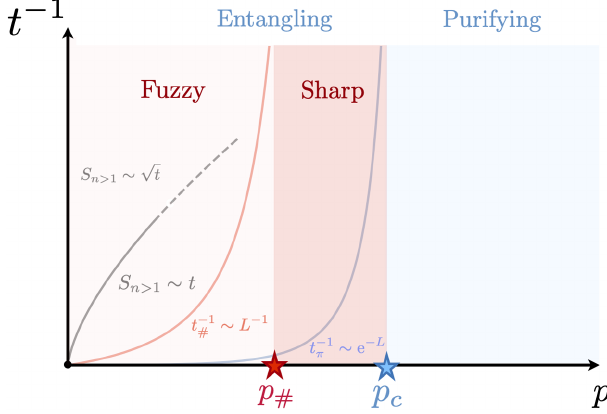
FIG. 1. Phase diagram and crossover timescales in U(1) symmetric monitored quantum circuits. Our numerical results indicate that there are two distinct phases in the entangling (volume-law) regime p < p , separated by a charge-sharpening c critical point as p ¼ p # . In the charge-fuzzy phase ( p < p # ), we identify three relevant timescales in the dynamics: For a large enough system, first (1) average R´enyi entropies crossover from ffiffi p ∼ t diffusive ½ S to ballistic ∼ t scaling over a timescale n> 1 (cid:2) ∼ p − 3 = 2 , then (2) charge sharpens after the crossover timescale t # ∼ L , and finally (3) the system purifies over a much longer timescale t π ∼ e L